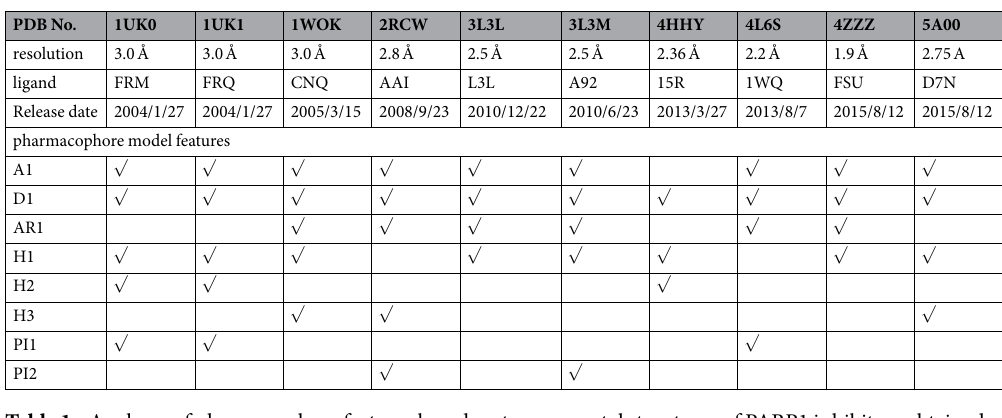
Table 1. Analyses of pharmacophore features based on ten co-crystal structures of PARP1 inhibitors obtained from the Protein Data Bank (PDB).